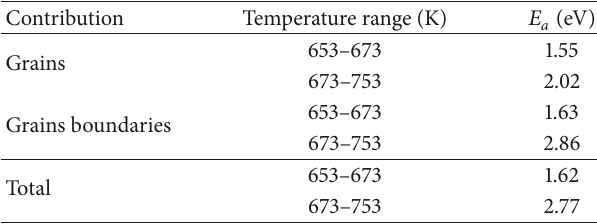
Figure 5: Variation of the blockage factor 𝛼 with temperature. Table 3: Activation energies in Na 2 K 2 Cu(MoO 4 ) 3